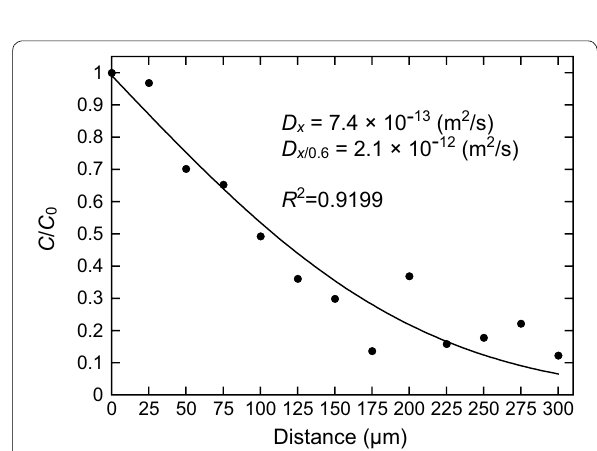
Fig. 11 Determination of the diffusion coefficients in the water‑ added deformation experiment. The water contents and distance correspond to the water absorption bands in Fig. 9, and the diffusion coefficient is shown as D x . The diffusion coefficient for the initial sam‑ ple length without 40% strain ( D x /0.6 ) is also shown for comparison. The coefficient of determination ( R 2 ) is